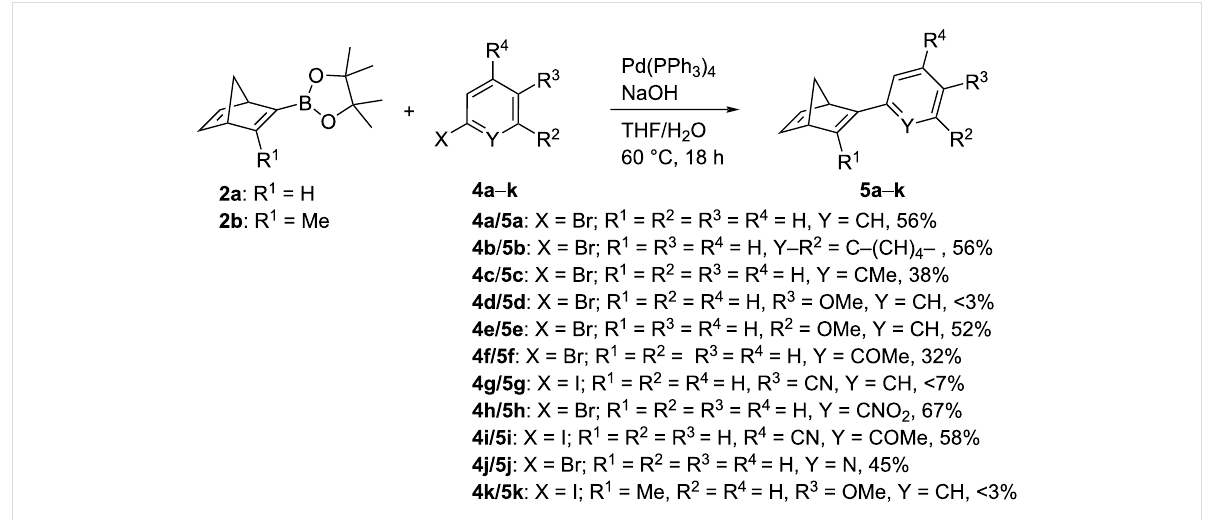
a Yield of isolated product 5a after column